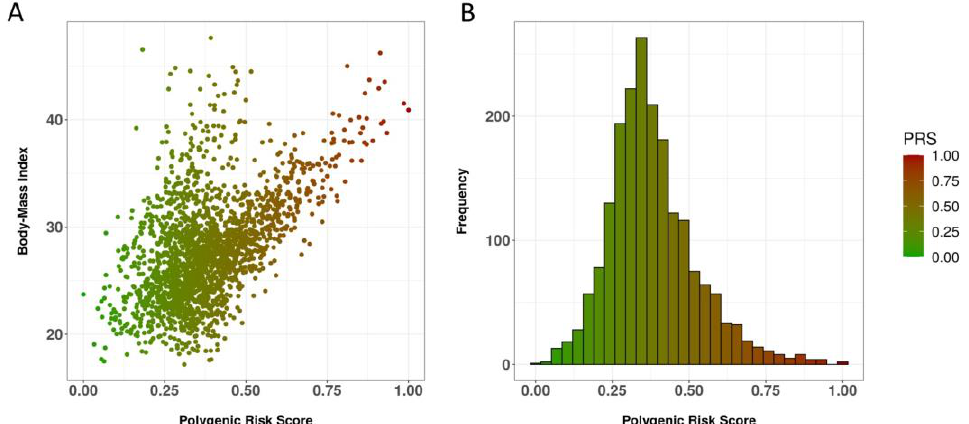
Figure 2. Correlation of the 343-SNP PRS for BMI with the phenotype and PRS distribution. ( A ). The BMI phenotype across the merged dataset is plotted against the min–max-normalized PRS value for each individual. ( B ). Histogram depicting the min–max-normalized PRS distribution for all individuals in the merged dataset. Table 3. List of PRS SNPs with known associated traits in GWAS Catalog.